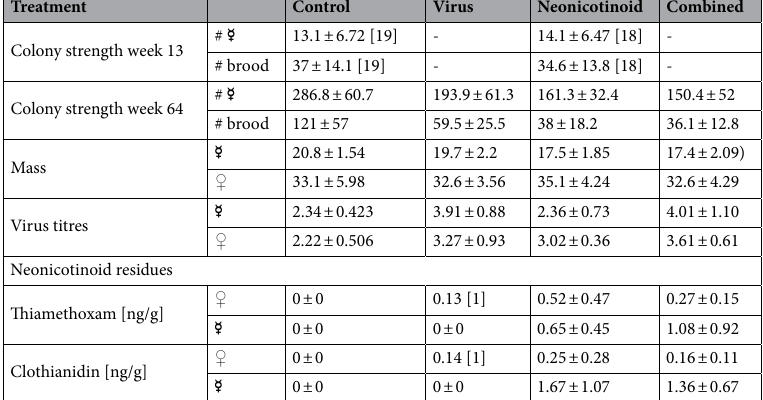
Table 1. Summary table of response variables. Mean ± standard deviation values for colony strength (week 13 & 64) measured as number of workers and amount of brood (eggs, larva and pupae), mass of Lasius niger queens ( ♀ ) and 20 pooled workers ( ☿ ), virus titres [log genomic virus copies / mg] and neonicotinoid residues [ng/g (dryweight) ] for the four treatment groups: (i) Controls, (ii) neonicotinoid = chronic exposure to thiamethoxam (30 ppb), (iii) virus = feeding regime with Acute bee paralysis virus (ABPV), (iv) combined = exposure to thiamethoxam and ABPV . N = 8 each unless specified differently in square brackets